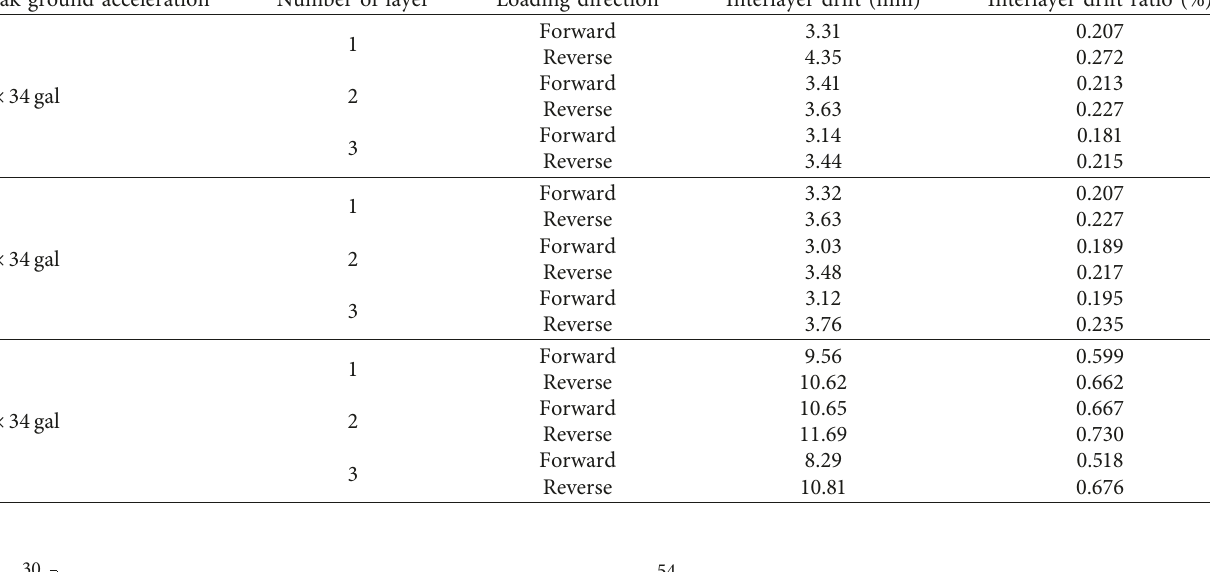
Table 2: Interlayer drift ratio of the prestressed fabricated concrete frame in different cases. Peak ground acceleration